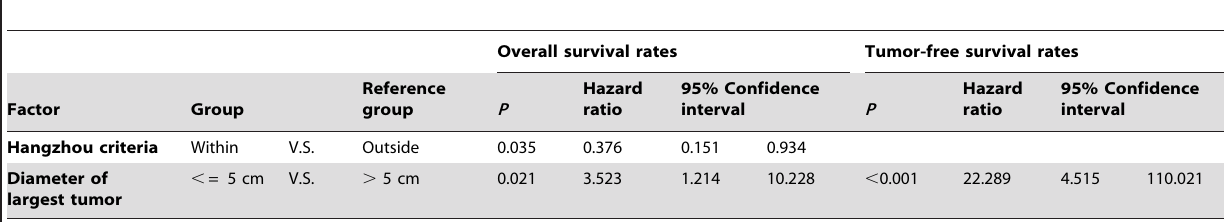
Table 4. Independent variables in the Cox analysis for overall and tumor-free survival (forward